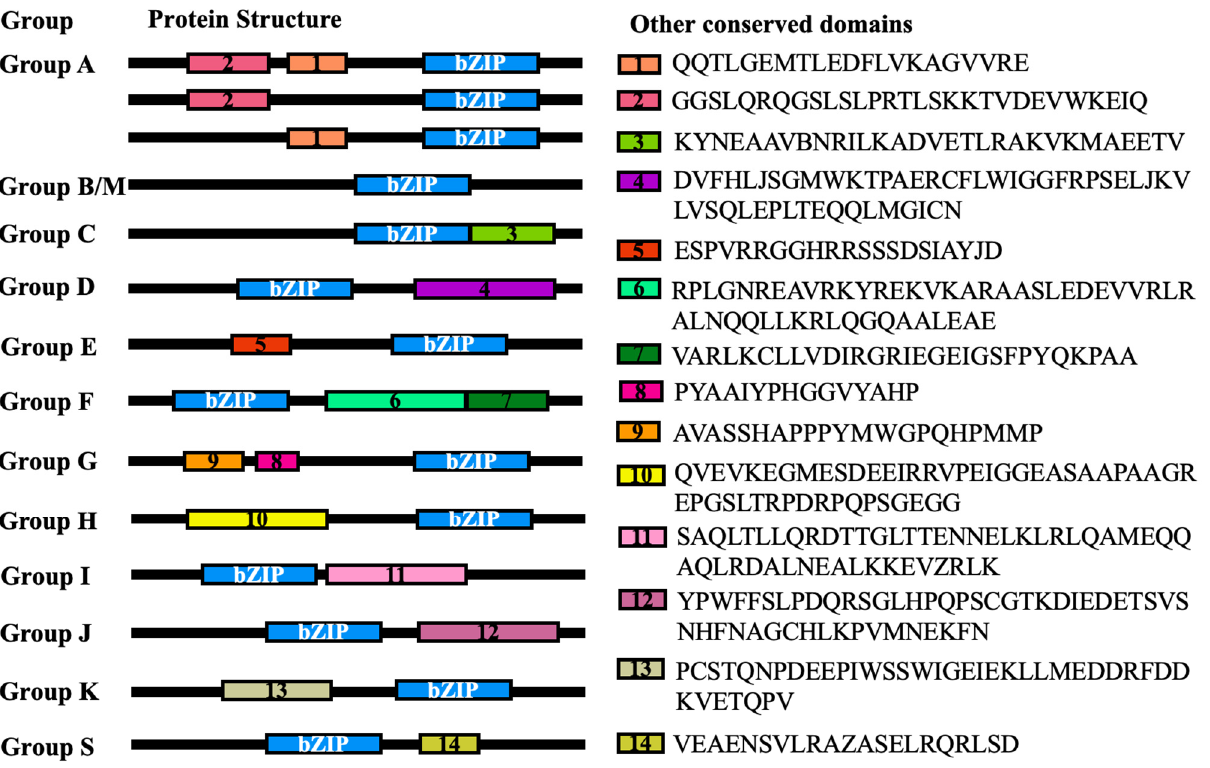
Figure 4. Conserved bZIP domains and additional conserved motifs present in GhbZIP proteins in different groups. The bZIP domains are shown in blue. Other conserved motifs outside the bZIP domain are highlighted in different color boxes with numbers 1 to 14, with details of conserved motifs on the right side.